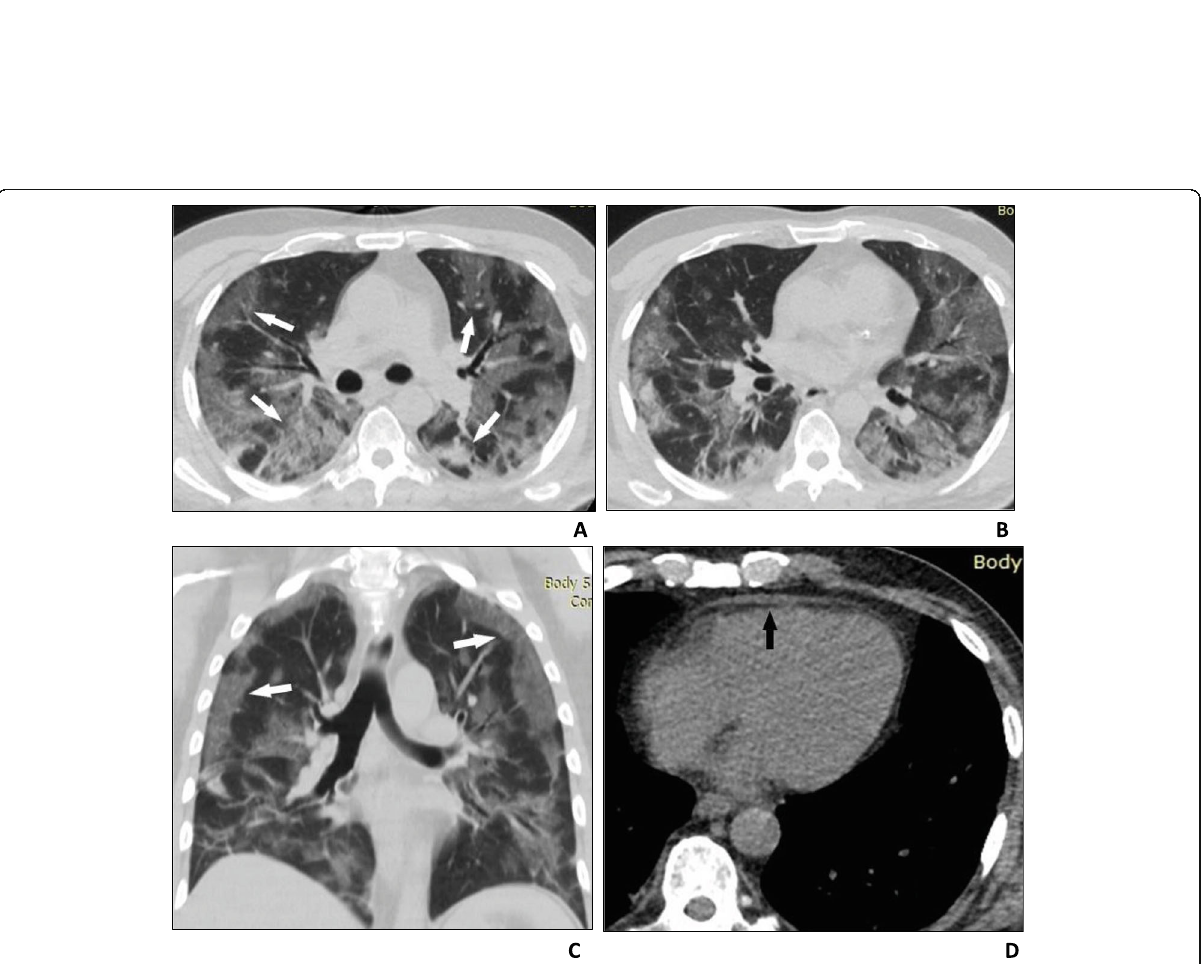
Fig. 2 A 66-year-old woman who presented with fever, productive cough, and dyspnea of 10 days duration. Her PaO 2 /FiO 2 ratio was 250 mmHg. Axial thin-section unenhanced CT images shows a a crazy-paving pattern with traction bronchiectasis and b ground-glass opacities with round configuration (black arrow) and posterior consolidation (white arrows)